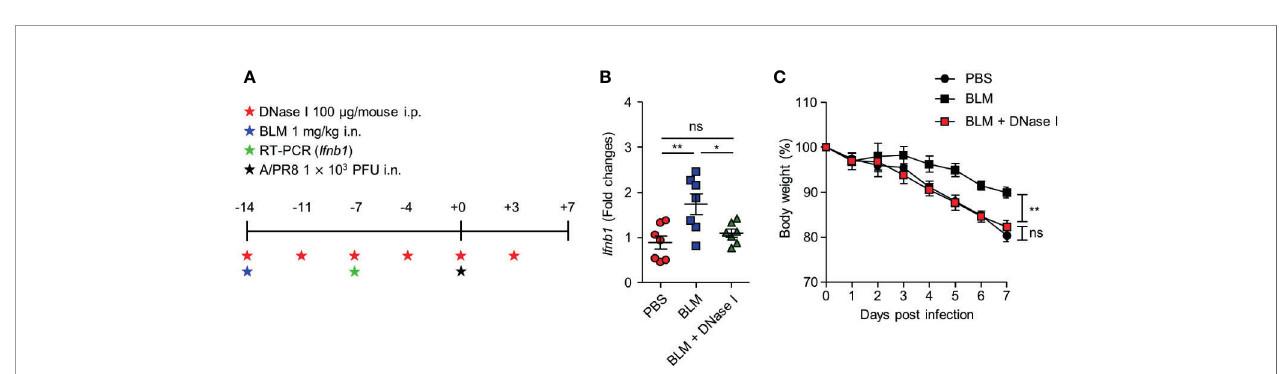
FIGURE 5 | DNase I treatment reduces IFN-I transcription and resistance to in fl uenza virus infection in BLM-treated mice. (A) Mice were administered BLM intranasally and DNase I intraperitoneally following the scheme. (B) Gene expression of Ifnb1 in lung was analyzed ( ● , n = 7; ■ , n =7; ▲ , n=7). (C) Body weight was monitored for 7 days ( ● , n = 6; ■ , n = 6; ■ , n = 8). Data are expressed as ±SEM and representative of 2 independent experiments. Statistical analysis was performed with One-way ANOVA for (B) and Two-way ANOVA for (C) (*p < 0.05, **p < 0.01). ns, not signi fi